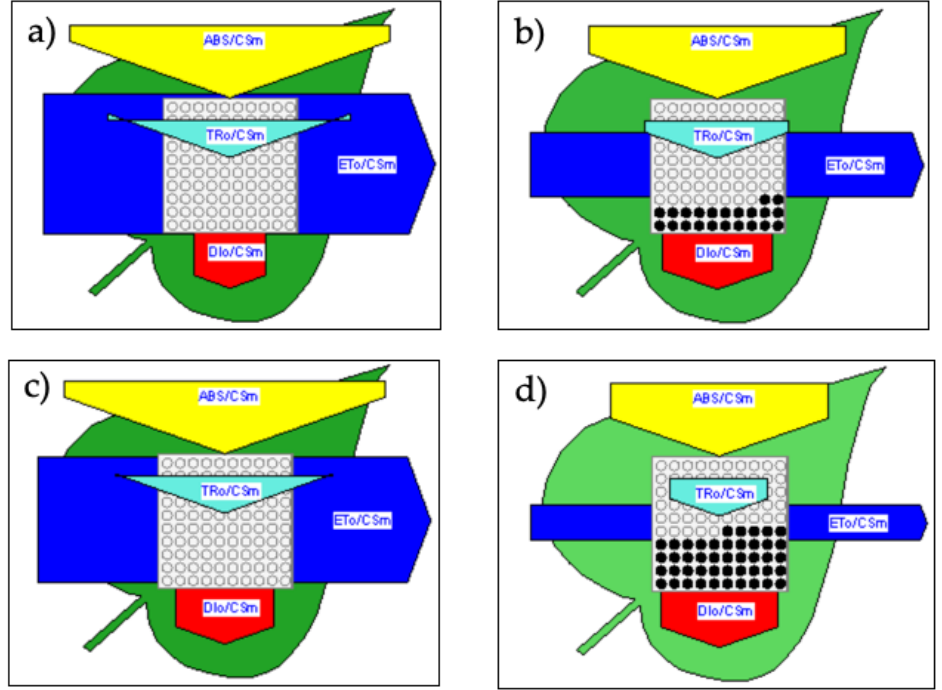
Figure 6. Pipeline models of energy fluxes per excited cross section (CS M ) of leaf sample, (phenomenological/leaf model) for S0 (panels a , c ) or S120 (panels b , d ) of QA (panels a , b ) or CG (panels c , d ). Each energy flux is depicted as an arrow, whose width is proportional to the relative flux. The deepness of the green color shows chlorophyll concentration per unit leaf surface. The number of active and silent reaction centers is given by the number of white and black circles, respectively. The software Biolyzer produced the pipelines from the average transient curve of 24 replicates measured on DAT